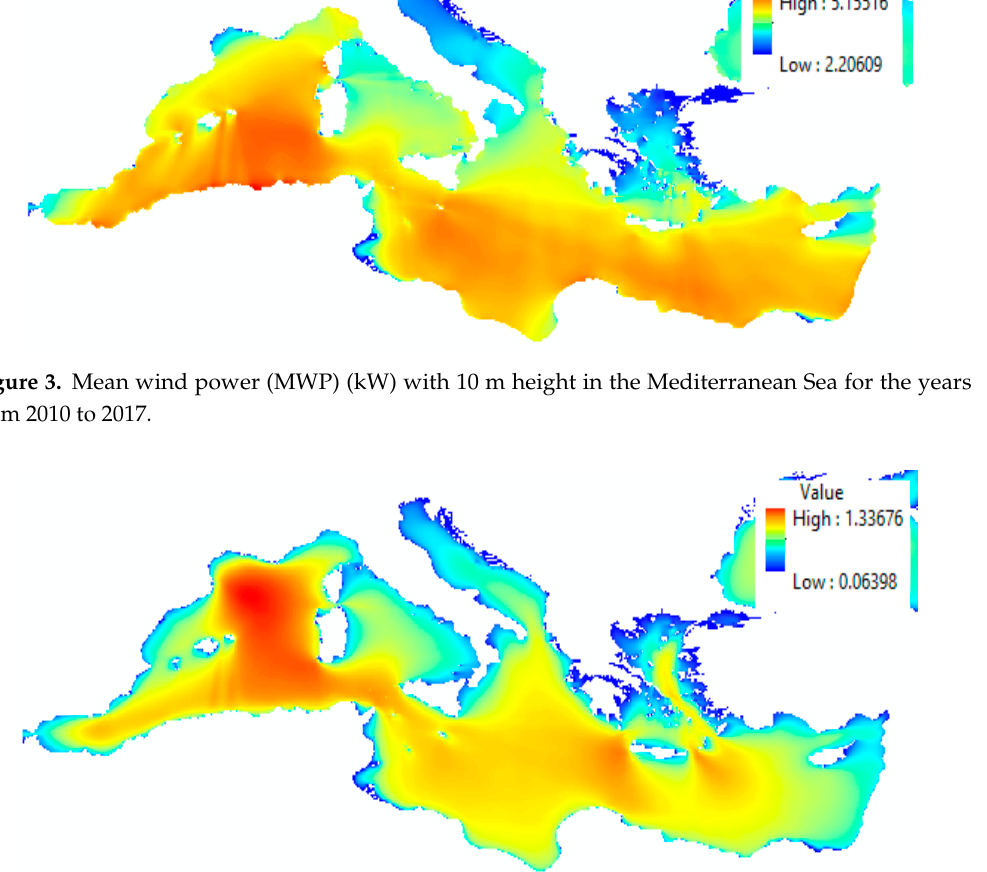
Figure 4. Significant wave height (SWH) (m) in the Mediterranean Sea averaged for the years from 2010 to 2017.